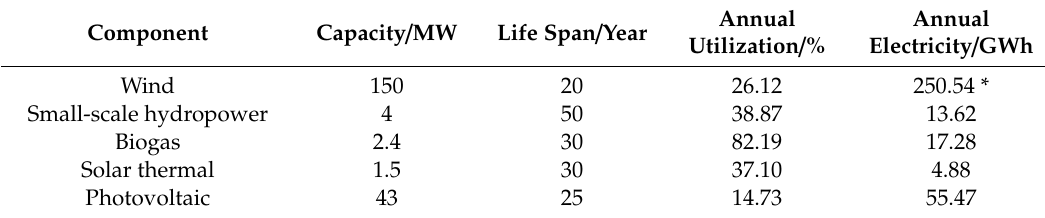
Table 2. Basic parameters of the distributed renewable energy system in Yanqing